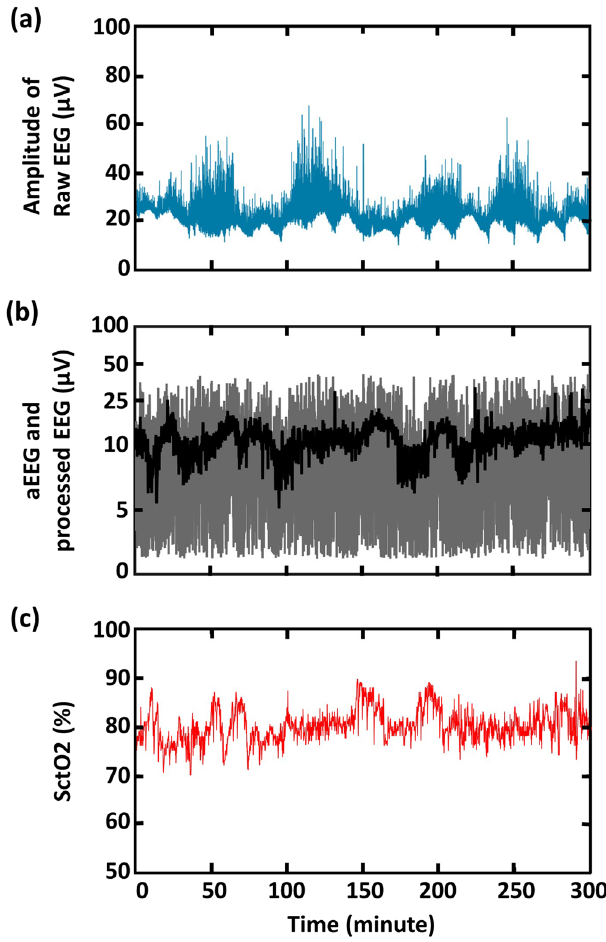
Figure 1. ( a ) An example of amplitude tracing of 5-h raw EEG recorded with a 256-Hz sampling. The y-axis represents amplitude of raw EEG in μV, plotted with a linear scale, while x-axis represents time in minute. ( b ) Three-step processed EEG tracing (processed EEG, gray trace) plotted together with aEEG (black trace) derived with WU-NEAT 7 . The y-axis represents amplitude of aEEG or processed EEG in μV, plotted with a linear scale between 0–10 μV and a log scale for any value larger than 10 μV. ( c ) The corresponding SctO2